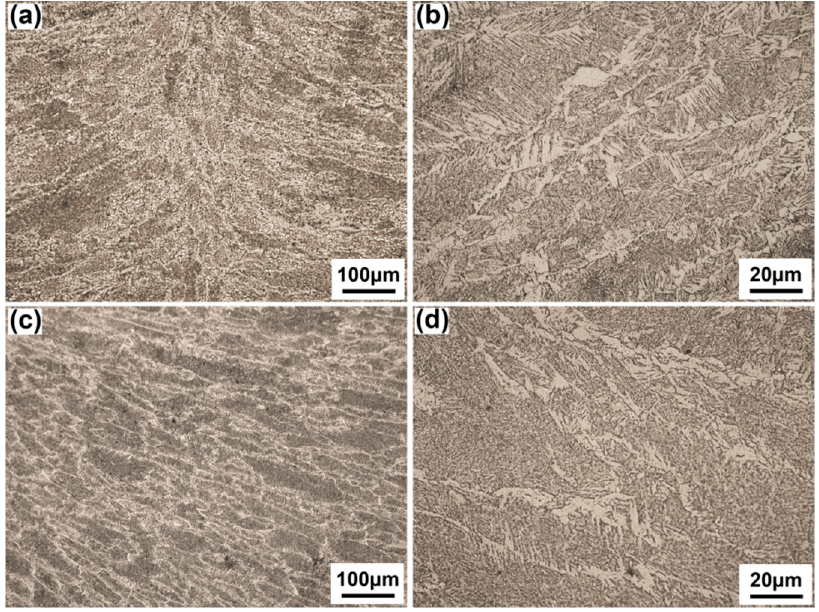
Figure 4. Microstructures of root layer, ( a ) laser zone; ( b ) amplified picture of ( a ); ( c ) arc zone; ( d ) amplified picture of ( c ).